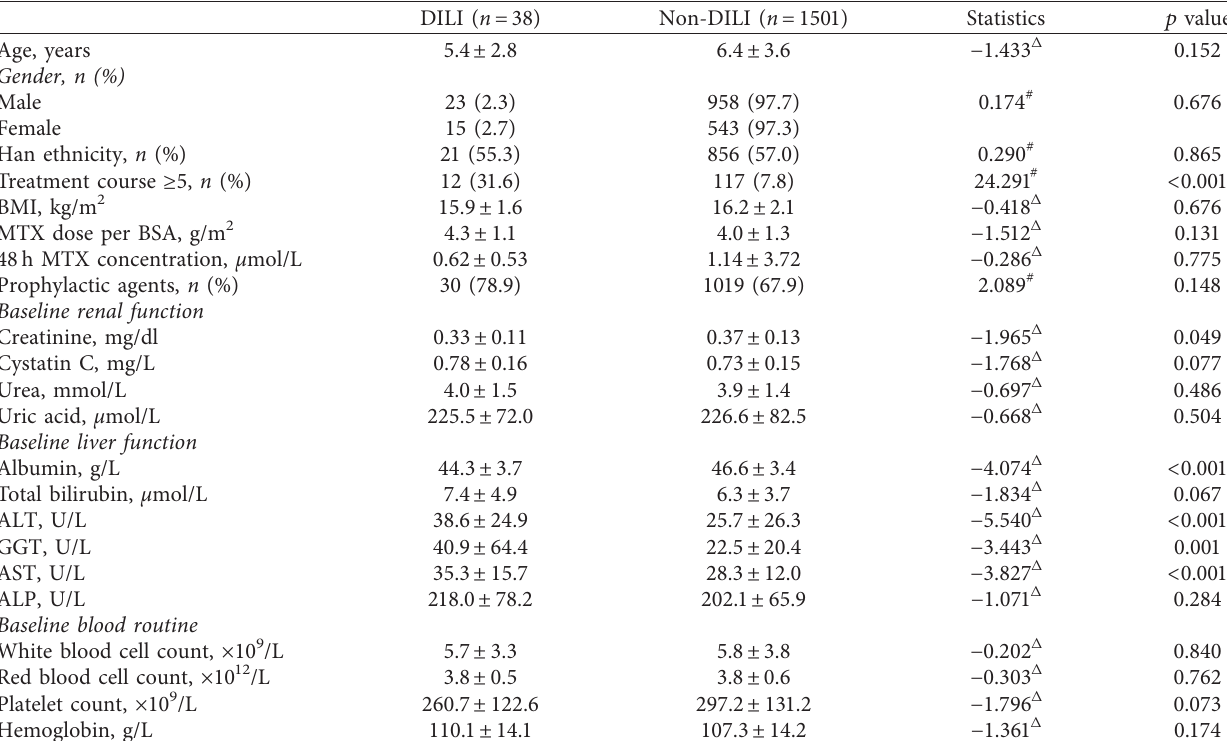
Table 3: Demographic and laboratory characteristics of DILI and non-DILI in SR/IR cases.